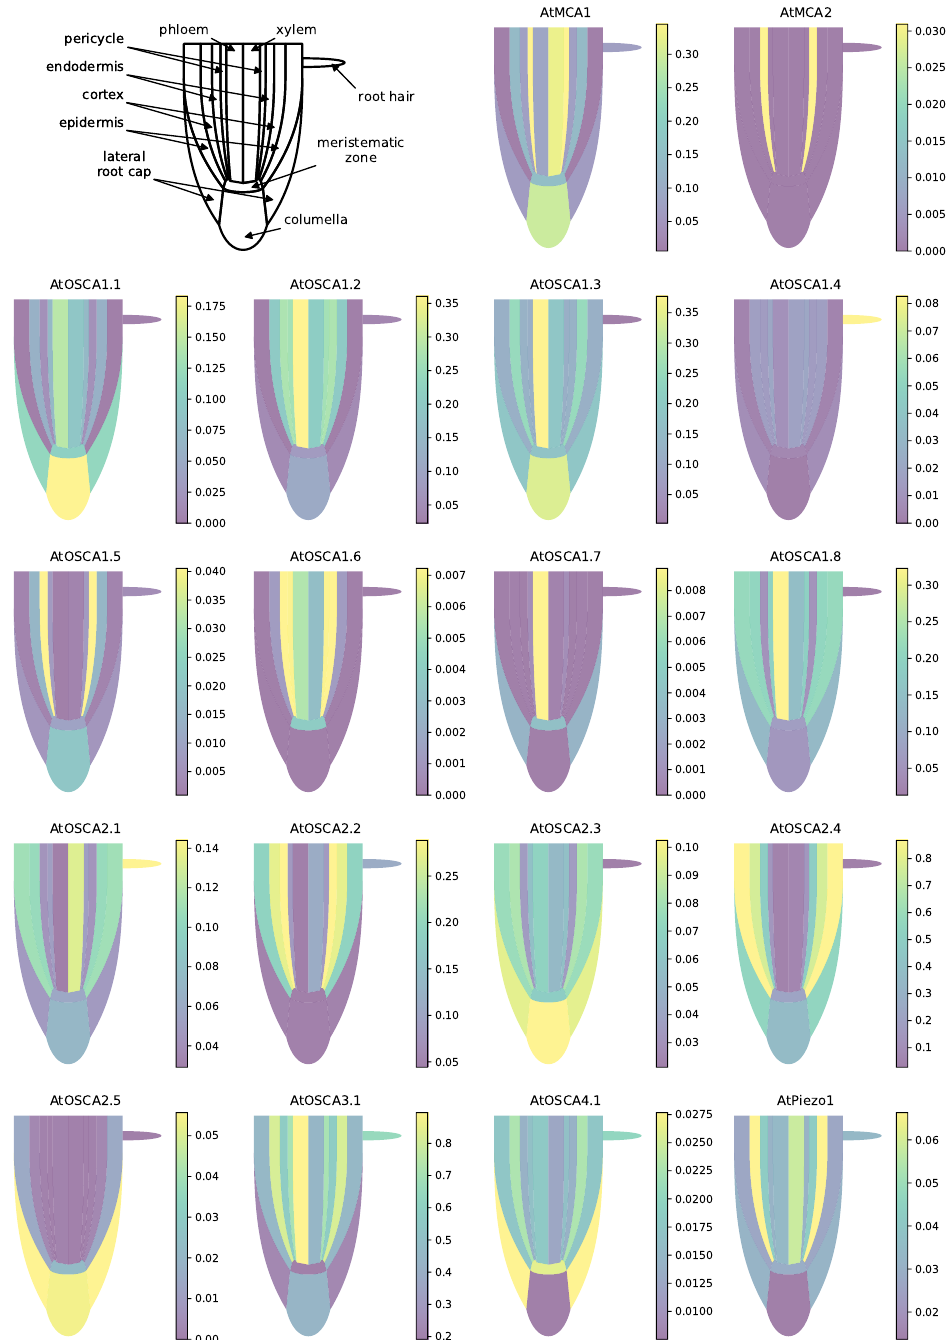
Figure 4. Expression patterns of MCA , Piezo and OSCA genes in different tissues of the Arabidopsis root. Data for each gene were retrieved from the BAR ePlantArabidospsis website (https://bar. utoronto.ca/eplant, accessed on 23 February 2021). To facilitate the graphical representation of expression levels in tissues, only expression values from sub-clusters containing differentiated (not differentiating) cells were used. In the stele, only the expression data from xylem- and phloem-cell types are shown. In the meristematic zone, we represented the expression mean of dividing cells and cells from the quiescent center. See Appendix B.1 for details and Table S1 for the relationships between gene names and accession